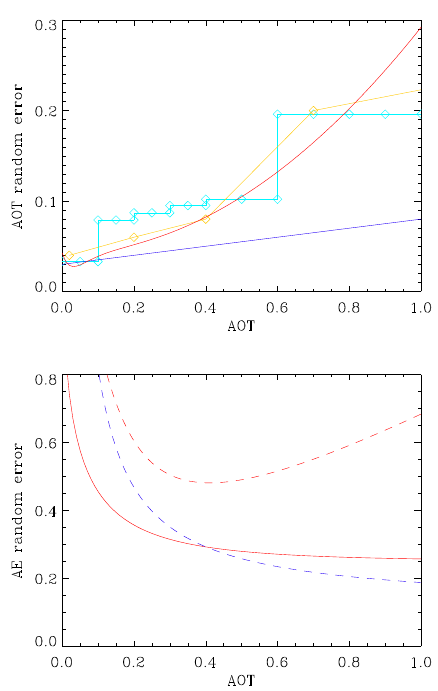
Fig. 20. Comparison of random error estimates for MODIS Aqua AOT and AE. In the top panel, AOT random errors estimated by Remer et al. (2005) (blue), Zhang and Reid (2006) (light blue), Shi et al. (2011) (orange) and this study (red). In the bottom panel, AE random errors estimated in this study (solid red). Also shown are er- rors predicted from Eq. (3) and AOT random errors estimated either by Remer et al. (2005) (dashed blue) or this study (dashed red).